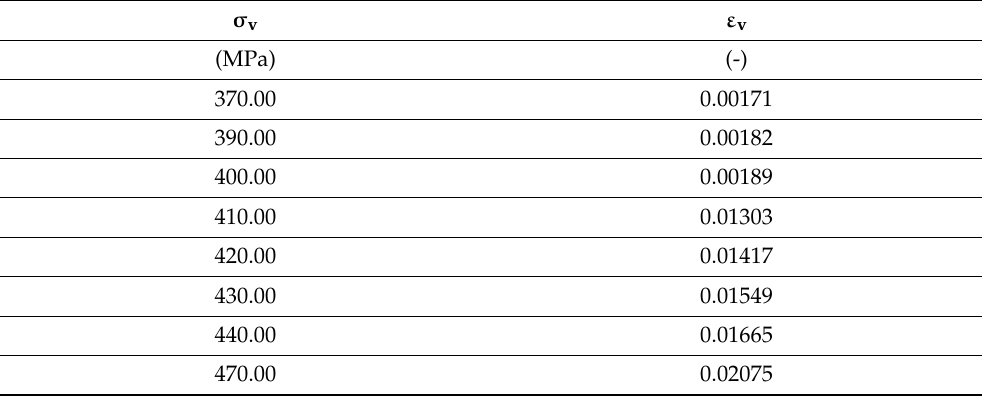
Table 3. Data from the tensile test for C45